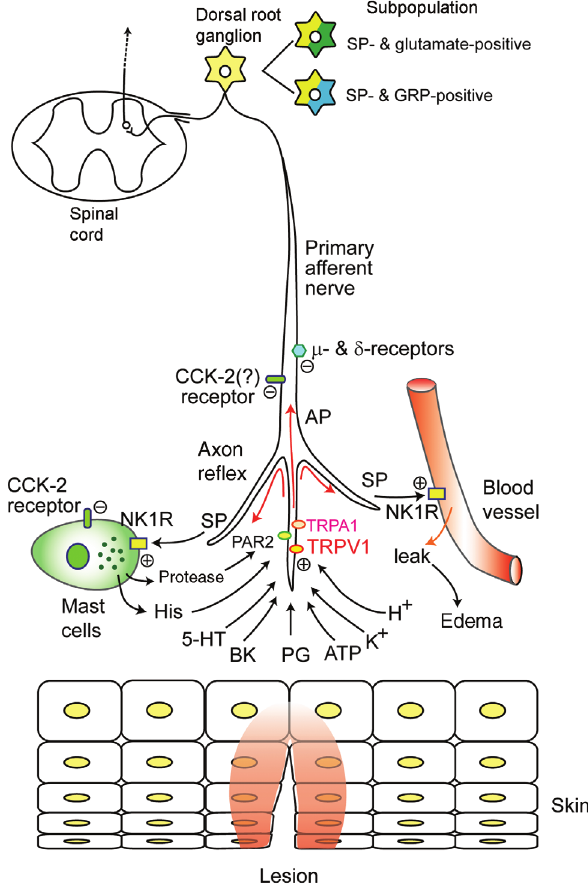
Figure 1 Substance P (SP)-containing primary afferent nerves and